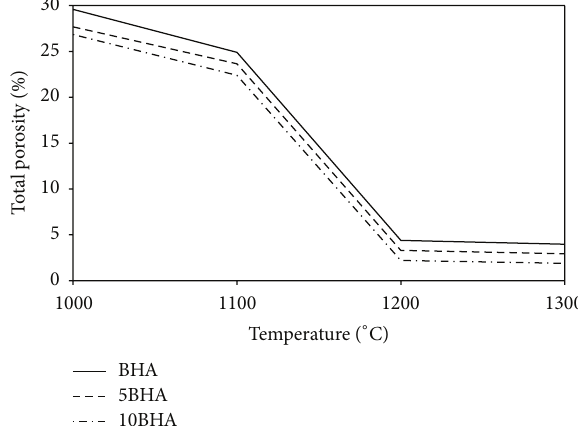
Figure 5: Variation of total porosity of sintered BHA, 5BHA, and 10BHA composites at different sintering